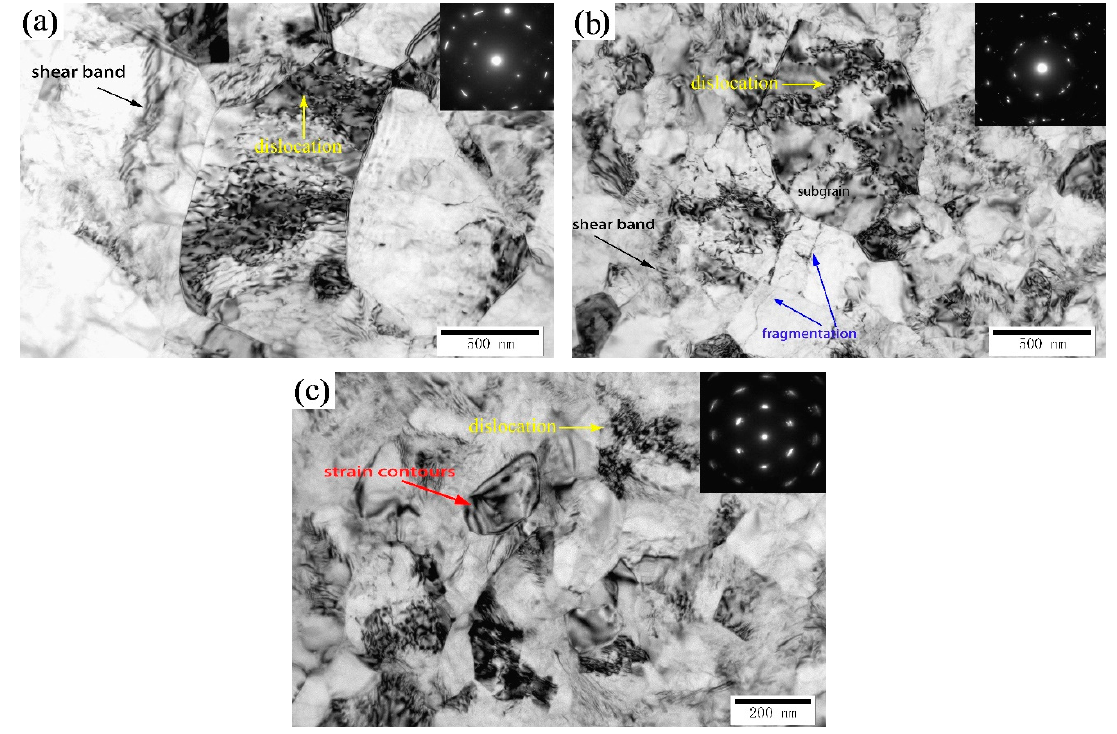
Figure 5. TEM images of CP Ti after MDF with ( a ) 1 cycle ( b ) 2 cycles ( c ) 3 cycles.